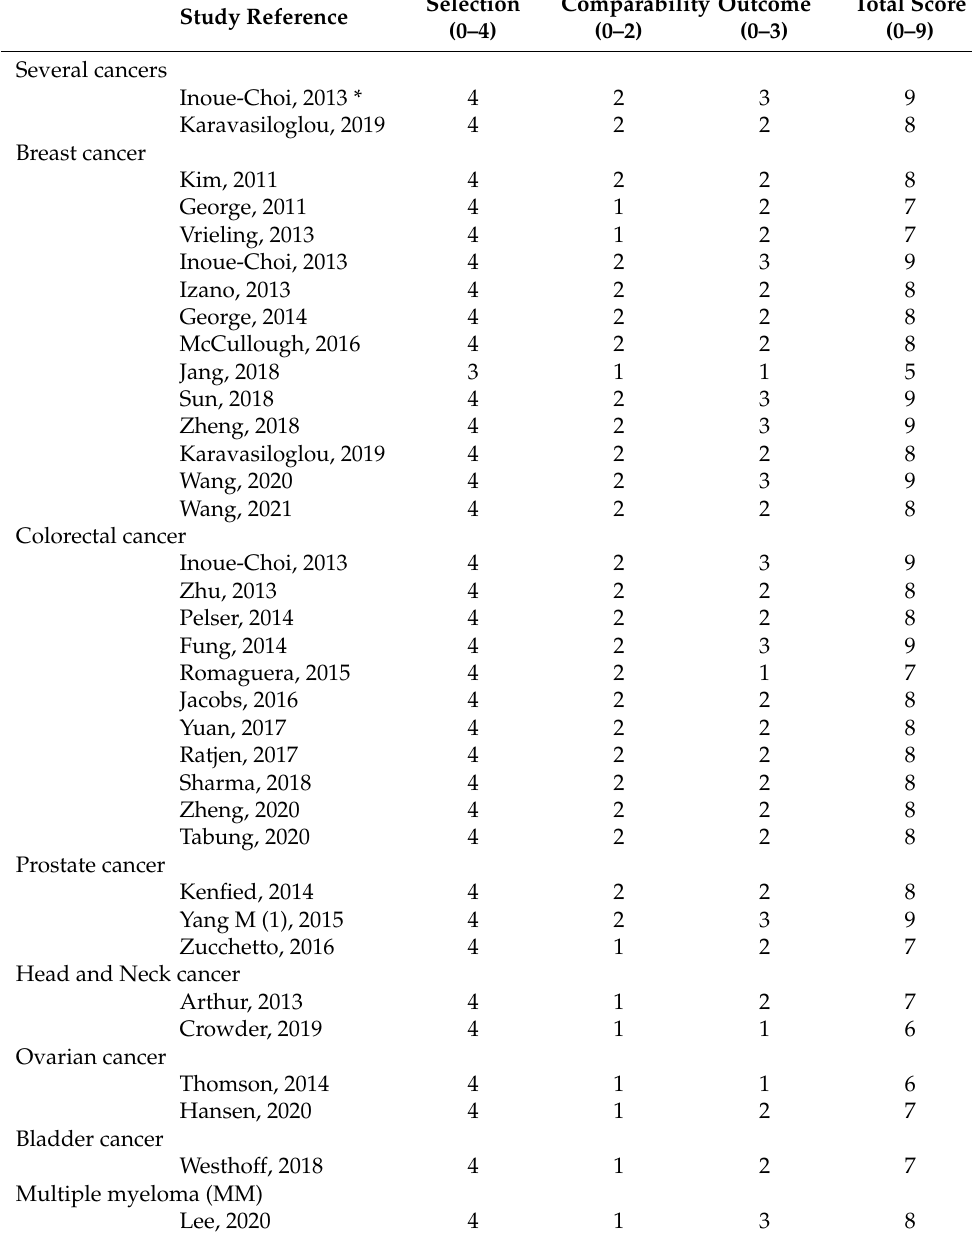
Table A1. Risk of bias assessment according to the Newcastle-Ottawa Scale (NOS) for cohort